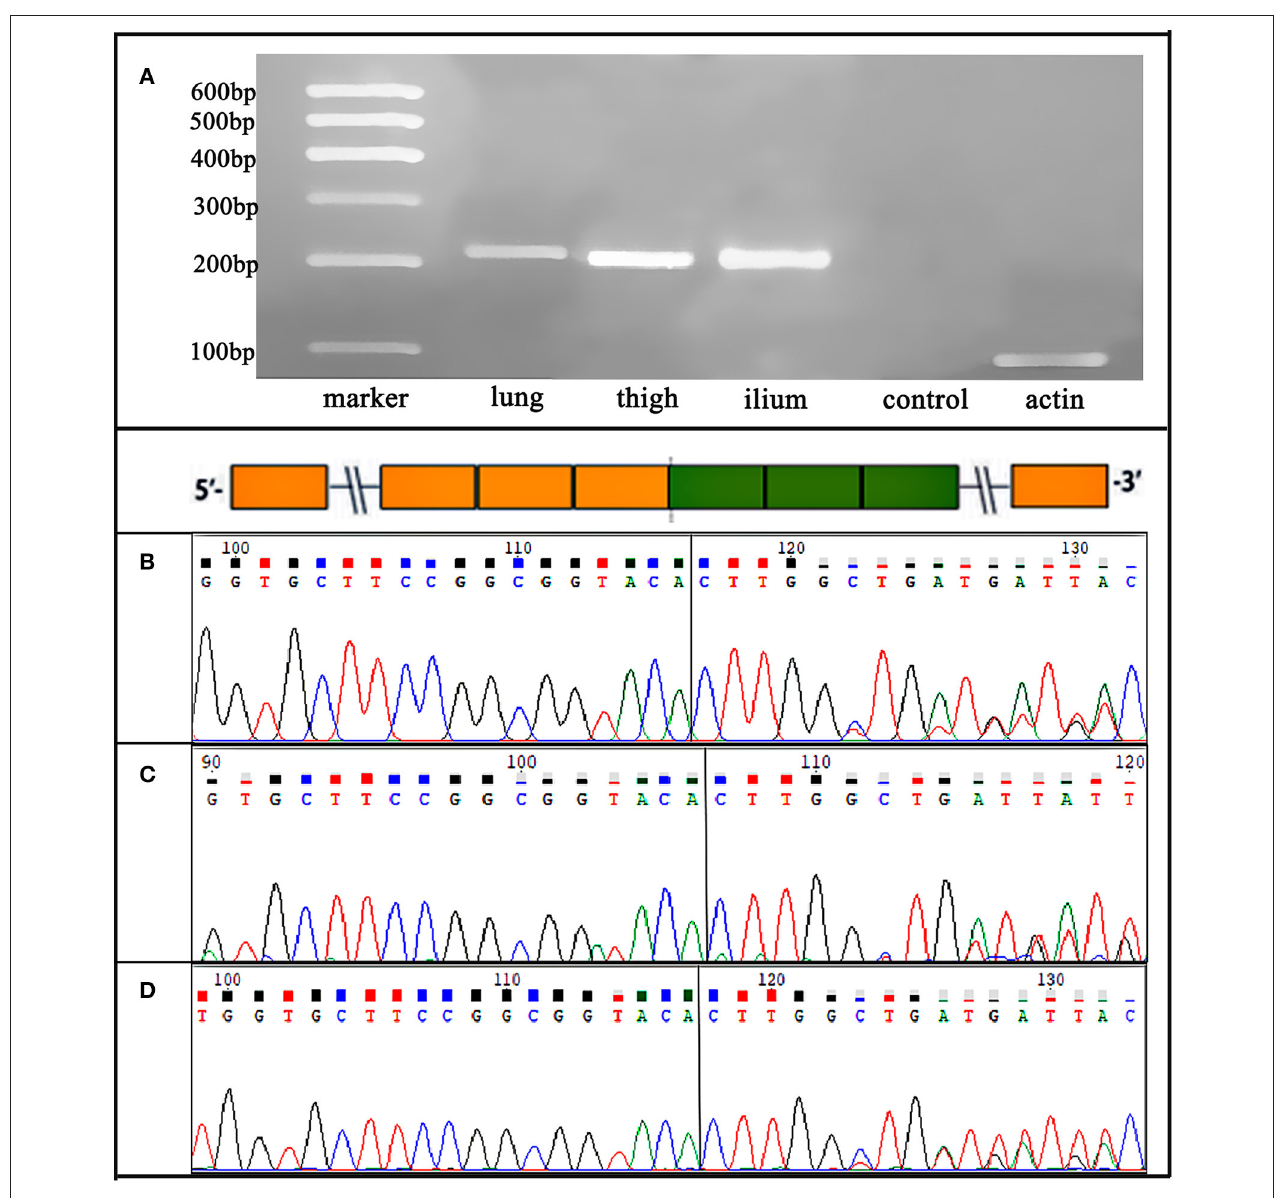
FIGURE 4 | Case 2. (A) RT-PCR for lung, right thigh, and ilium lesions confirmed an EML4-ALK fusion variants, which were detected by NGS. (B-D) Sanger sequencing verified the sequence of the EML4 (exon 6) -ALK (exon 20) fusion transcript in the three primary and metastatic lesions.